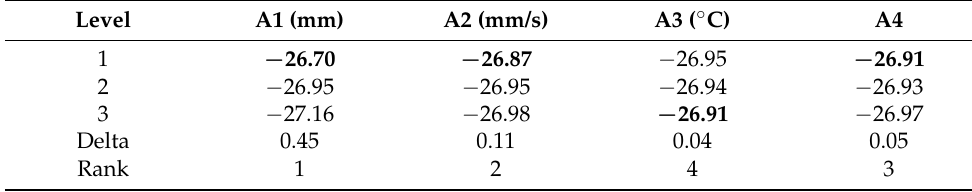
Table A3. Mean S/N ratio response table for Ra-PA-6 polymer.